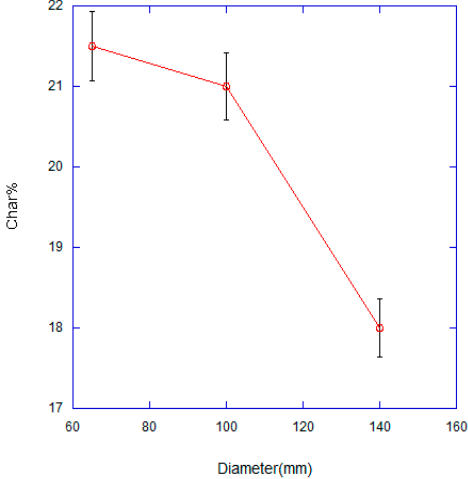
Figure 11. Char left versus diameter.